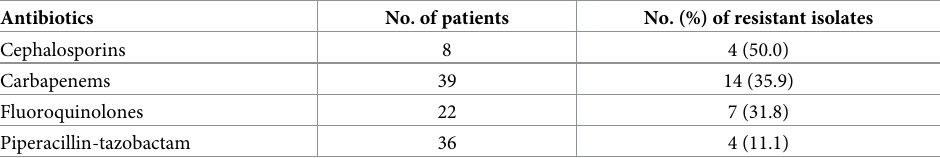
Table 2. Correlation between antibiotics received for > 48 hours within 30 days and isolates resistant to the same antibiotic class.